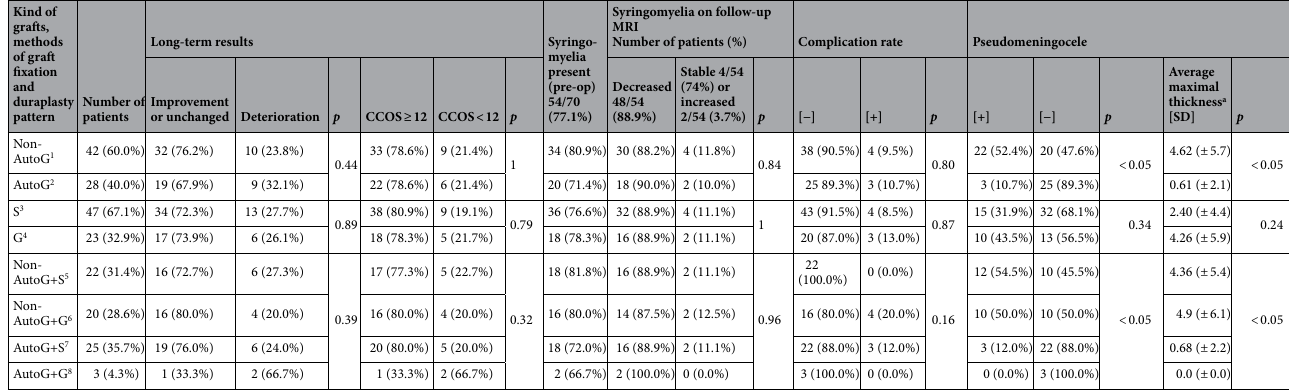
Mean decrease in size of syringomyelia Graft and methods of graft fixation Length -number of spinal segments (SD)